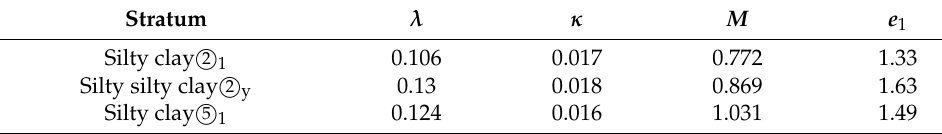
Table 2. Parameters of the Cambridge model of the soil